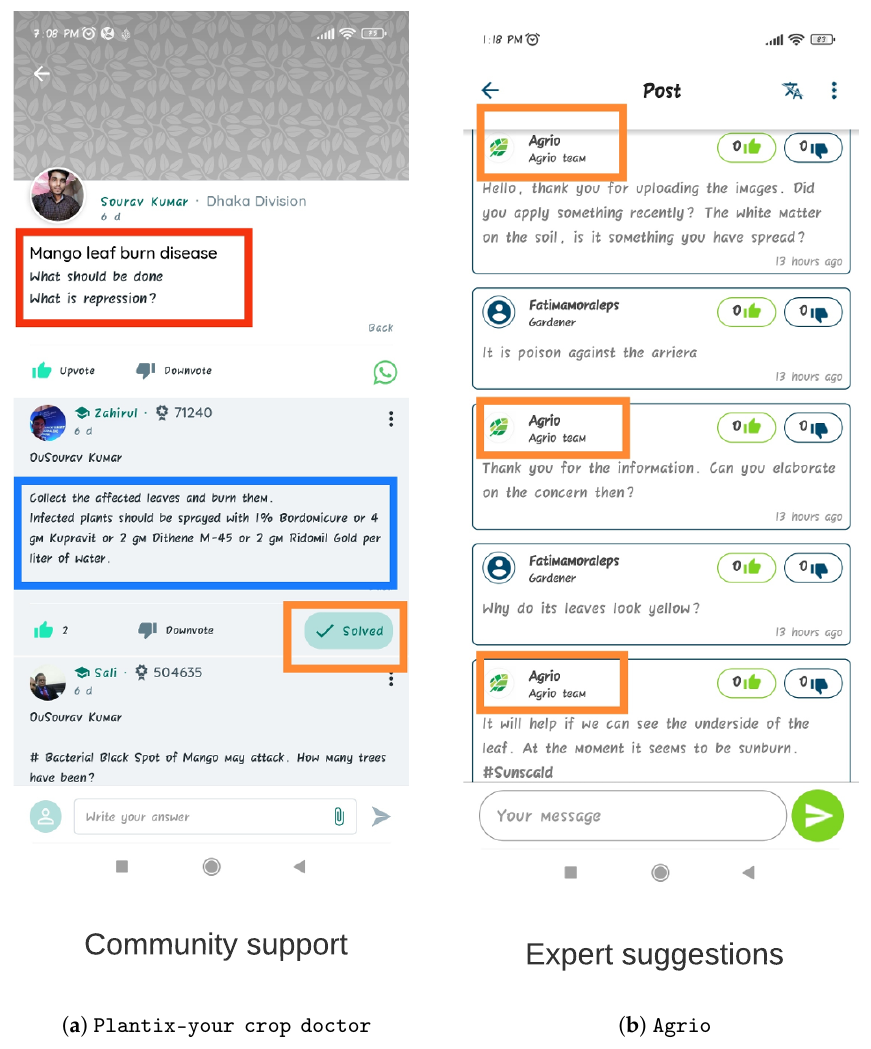
Figure 8. Expert/community support.